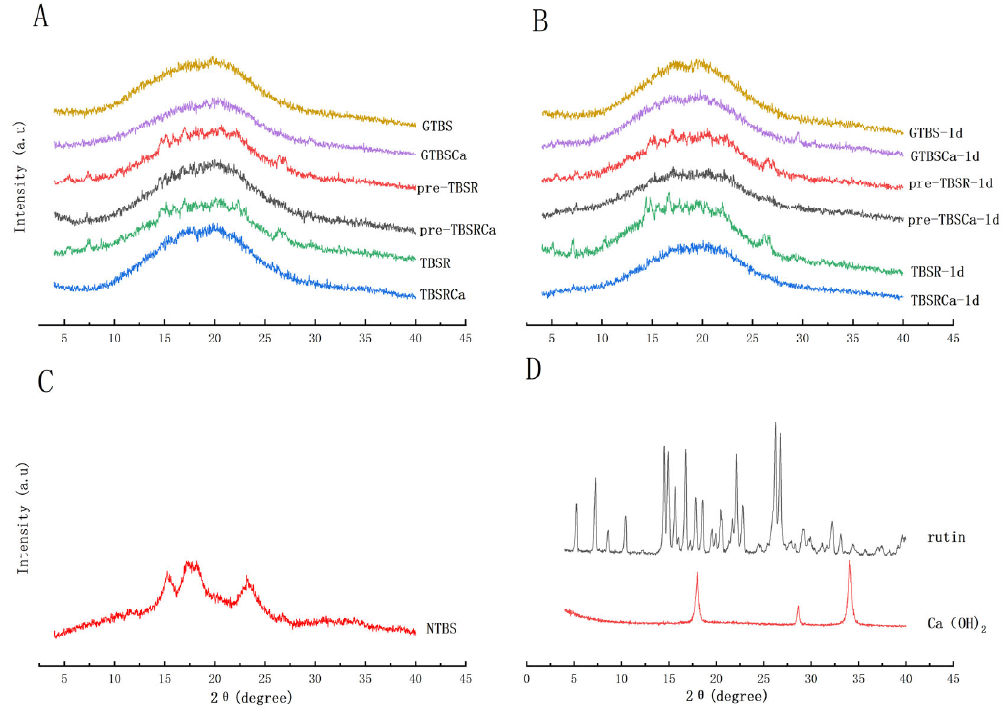
Figure 4. X-ray pattern of GTBS, GTBSCa, pre-TBSR, pre-TBSRCa, TBSR and TBSRCa complexes ( A ) and retrograded samples for 1 day ( B ); NTBS ( C ); Ca(OH) 2 ; rutin ( D ). Table 1. Relative crystallinity (RC) and the ratio of 1047/1022 cm − 1 (DO) of samples.